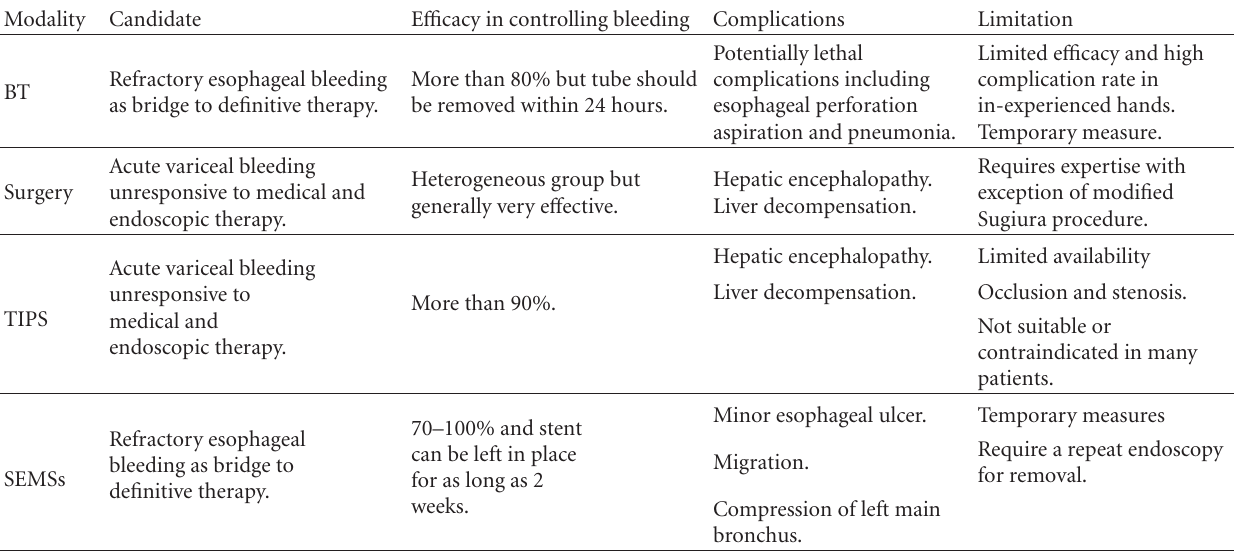
Table 2: Rescue therapies for refractory esophageal variceal